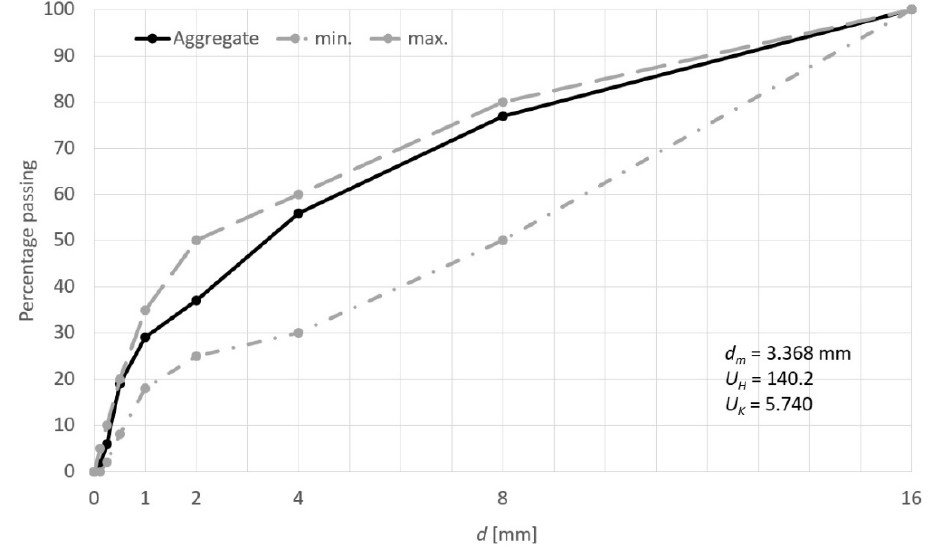
Figure 1. Grading curve of the used natural aggregates blend with the grading requirements.